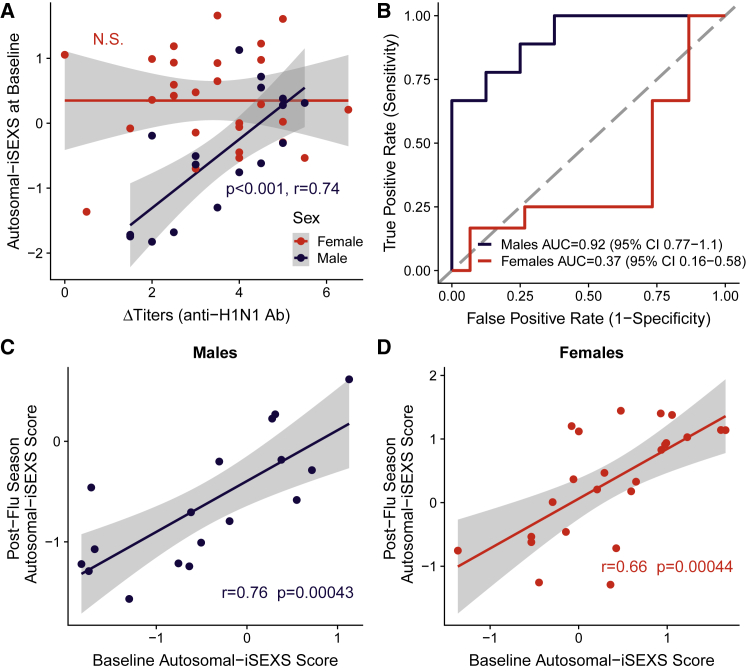
Autosomal-iSEXS Score Prior to Influenza Infection Predicts Antibody Response, but Only in MalesIn GSE68310, healthy volunteers were followed at the beginning of flu season (baseline), during community-acquired influenza A infection and in the spring following flu season (post-flu season).(A) Autosomal-iSEXS scores correlate with the change in anti-H1N1 antibody titers in males (p < 0.001, Pearson's r = 0.74), but not females. Grey area indicates a 95% confidence interval.(B) Autosomal-iSEXS scores predict responder status in males (AUC = 0.92; 95% CI, 0.77-1.1), but not females (AUC = 0.37; 95% CI, 0.16-0.58).(C and D) Male (C) and female (D) autosomal-iSEXS scores at baseline significantly correlate with post-flu season scores. Pearson's correlation coefficient and p value are given. Grey area indicates a 95% confidence interval.See Figure S5 for XY-iSEXS score performance.